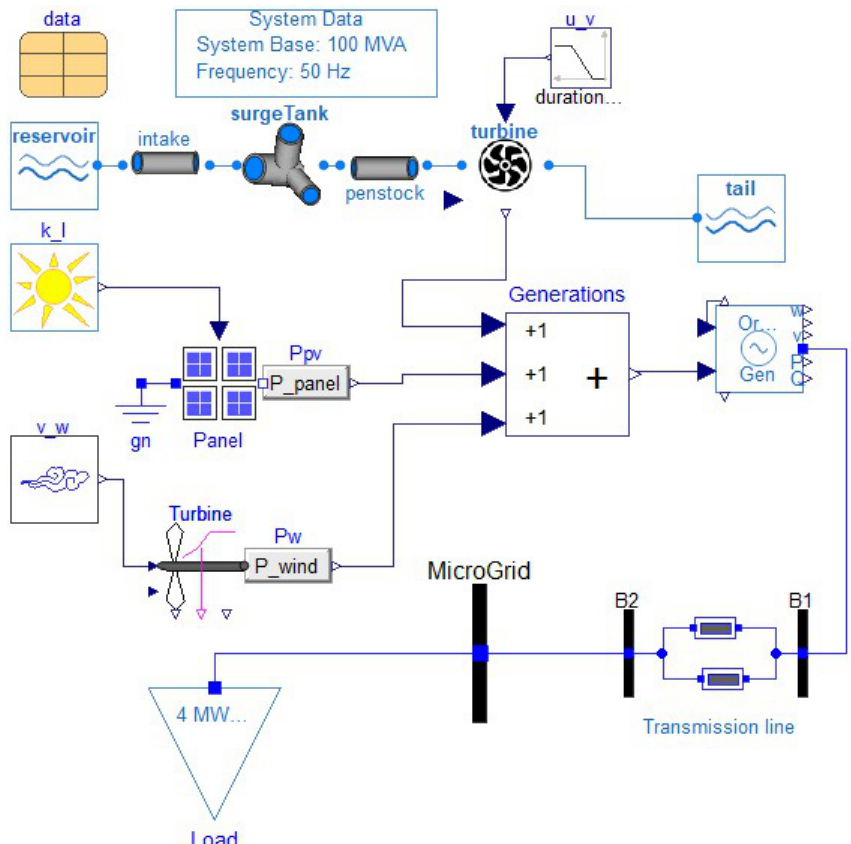
Figure 9. Simulation model developed in OpenModelica using Modelica libraries, OpenHPL, OpenIPSL, PhotoVoltaics, and